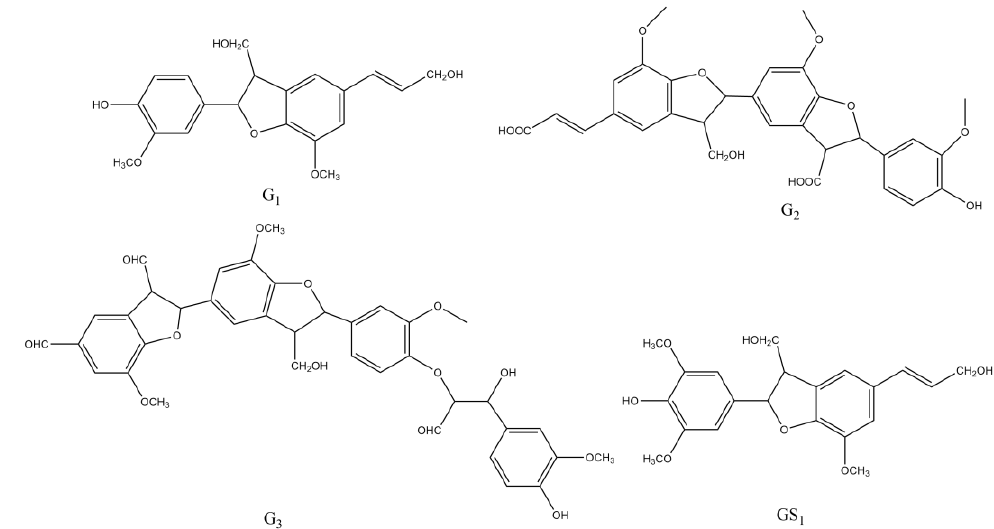
Figure 15. Chemical structure of the compound G 1 , G 2 , G 3 , and GS 1 with significant antibacterial